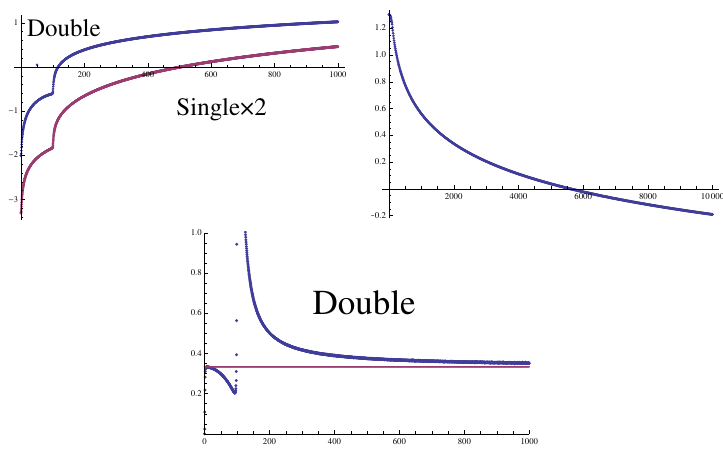
Figure 18 . The behaviors of holographic entanglement entropy as a function of the time t when the subsystem A is almost semi-in(cid:12)nite. We chose A = [51 ; 10 6 ] and a = 1 ; b = 50. In the left picture, we plotted (cid:1) S dis for the double quench (blue) and the sum of two singles quenches (red) as a function A of time. In the middle picture we plotted the di(cid:11)erence (cid:1) S dis ;D function of time. In the right graph, we plotted t d (cid:1) S geodesic contribution) for the double joining quench as a function of